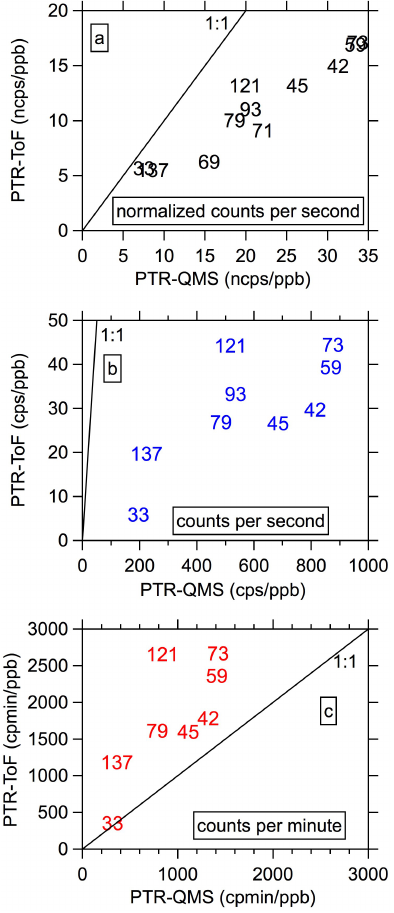
Figure 3. (a) PTR-QMS and PTR-TOF sensitivity in ncpsppbv − 1 normalized to 1 × 10 6 H 3 O + ions. (b) Sensitivity in cpsppbv − 1 with PTR-QMS 25 × 10 6 and PTR-TOF 1.6 × 10 6 H 3 O + ions. (c) Sensitivity in cpminppbv − 1 with PTR-QMS measuring 37 ions. The numbers in (a) , (b) and (c) are the nominal mass of the cali- brated compounds.